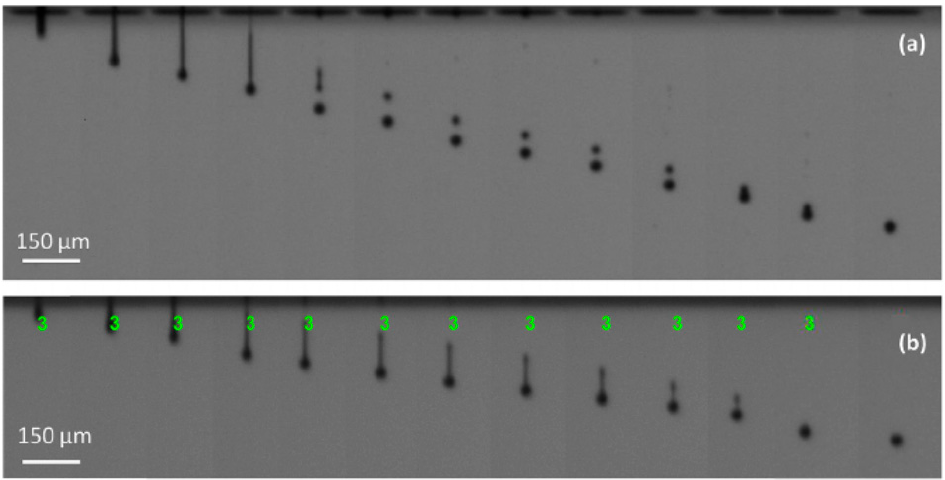
Figure 25. The colloidal LSM dispersions are stabilized using electrostatic dispersants which are commercially available from different manufacturers, as shown in Table 8.